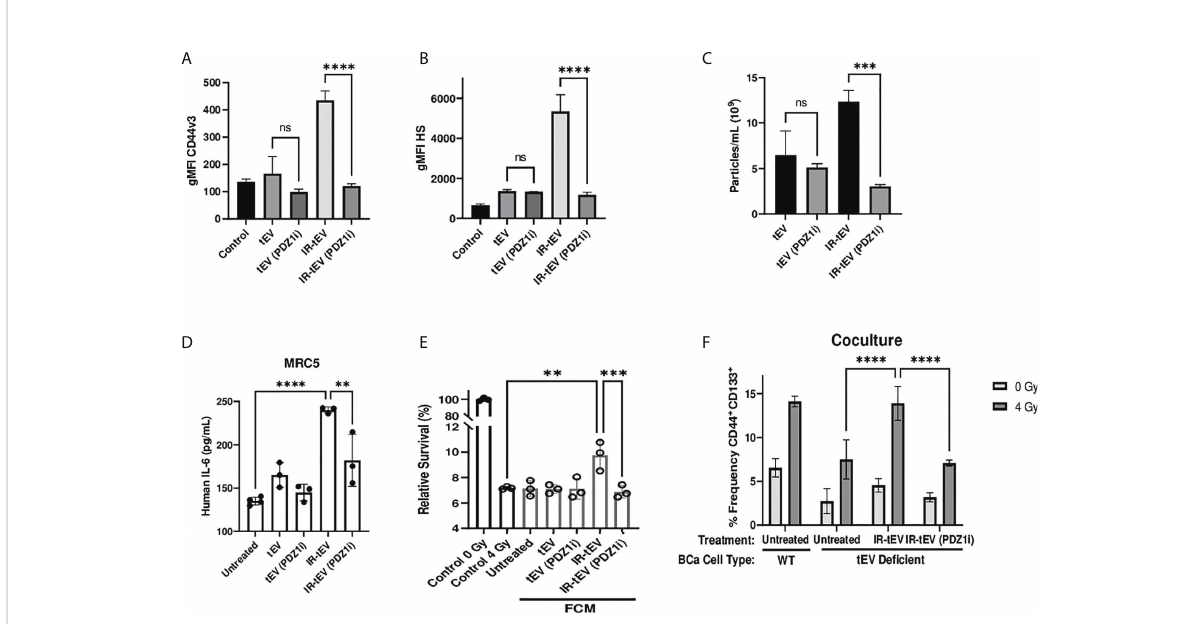
FIGURE 5 Pharmaceutical inhibition of the ESCRT pathway effectively silences IR-tEV activity. (A-C) tEVs were collected from untreated MB-MDA-231 cells or cell treated with 5 uM PDZ1i and CD44v3 (A) and HS (B) levels were assessed via bead assisted fl ow cytometry and overall tEV production (C) was assessed using the Zetaview Particle Tracker. (D) MRC5 cells were incubated with tEVs from PDZ1i treated MDA-MB-231 cells and IL-6 levels were measured via ELISA (E) MDA-MB-231 were exposed to fresh media containing FCM described in (D) and radioresistance was assessed via clonogenic assay. X axis indicates which FCM from (D) was used in each group. (D-E) Data points represent biological replicates. (F) WT or SDC1 Kd (tEV De fi cient) MDA-MB-231 cells were cultured with MRC5 cells with or without the addition of WT tEVs. Protein surface markers were assessed via fl ow cytometry. ** denotes a P value < 0.005. *** denotes a P value < 0.0005. **** denotes a P value < 0.00005. These values were the results of ANOVA analyses performed on GraphPad. “ ns ” represents a value for P that is greater than 0.05 and stands for “ Not Signi fi cant ”